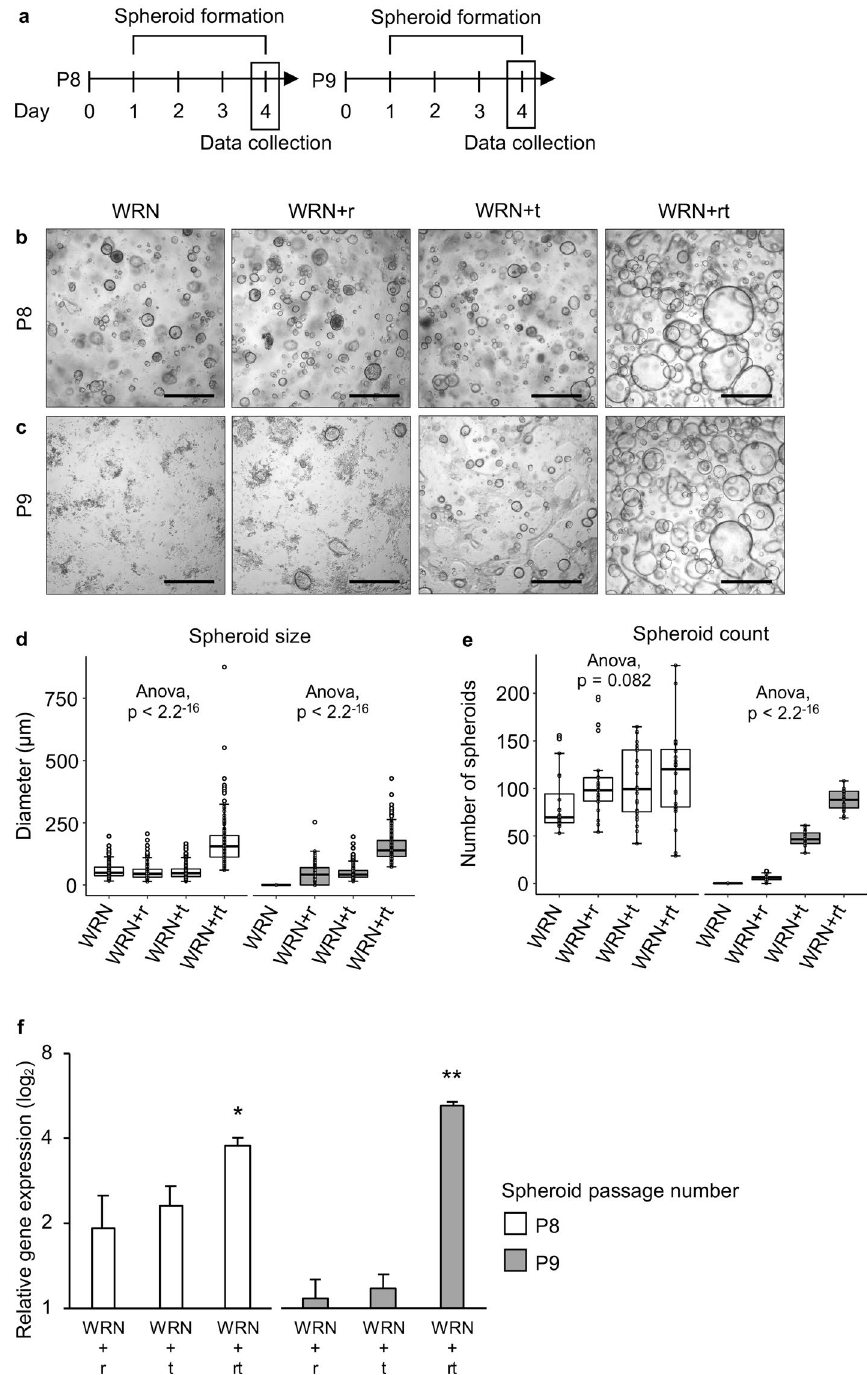
Figure 2. Effect of ROCK and TGB-β inhibitors on the growth of rabbit intestinal spheroids. ( a ) Experimental design. Proliferating spheroids generated from a single laboratory rabbit were passaged 8 and 9 times (P8 and P9, respectively) before they were cultured for four days in proliferation medium without inhibitors (WRN), with ROCK inhibitor (WRN + r), with TGF-β inhibitor (WRN + t), or with both inhibitors (WRN + rt). ( b , c ) Representative brightfield images of rabbit duodenal spheroids cultured in different media for two passages. Scale bars = 500 μm. ( d ) Spheroid diameter and ( e ) number of spheroids after culturing in different proliferation media. ( f ) Expression of the proliferation marker MKI67 in rabbit duodenal spheroids cultured in different media. Data are presented as fold change (2 −ΔΔCt ) in gene expression to spheroids cultured in WRN media without inhibitors, calculated from three individual cell culture wells with three technical RT-qPCR replicates each. Error bars represent standard errors of the mean. One-way ANOVA followed by Tukey’s honest significance test was performed to assess the statistical significance; only statistically significant differences are shown (* p < 0.05, ** p <